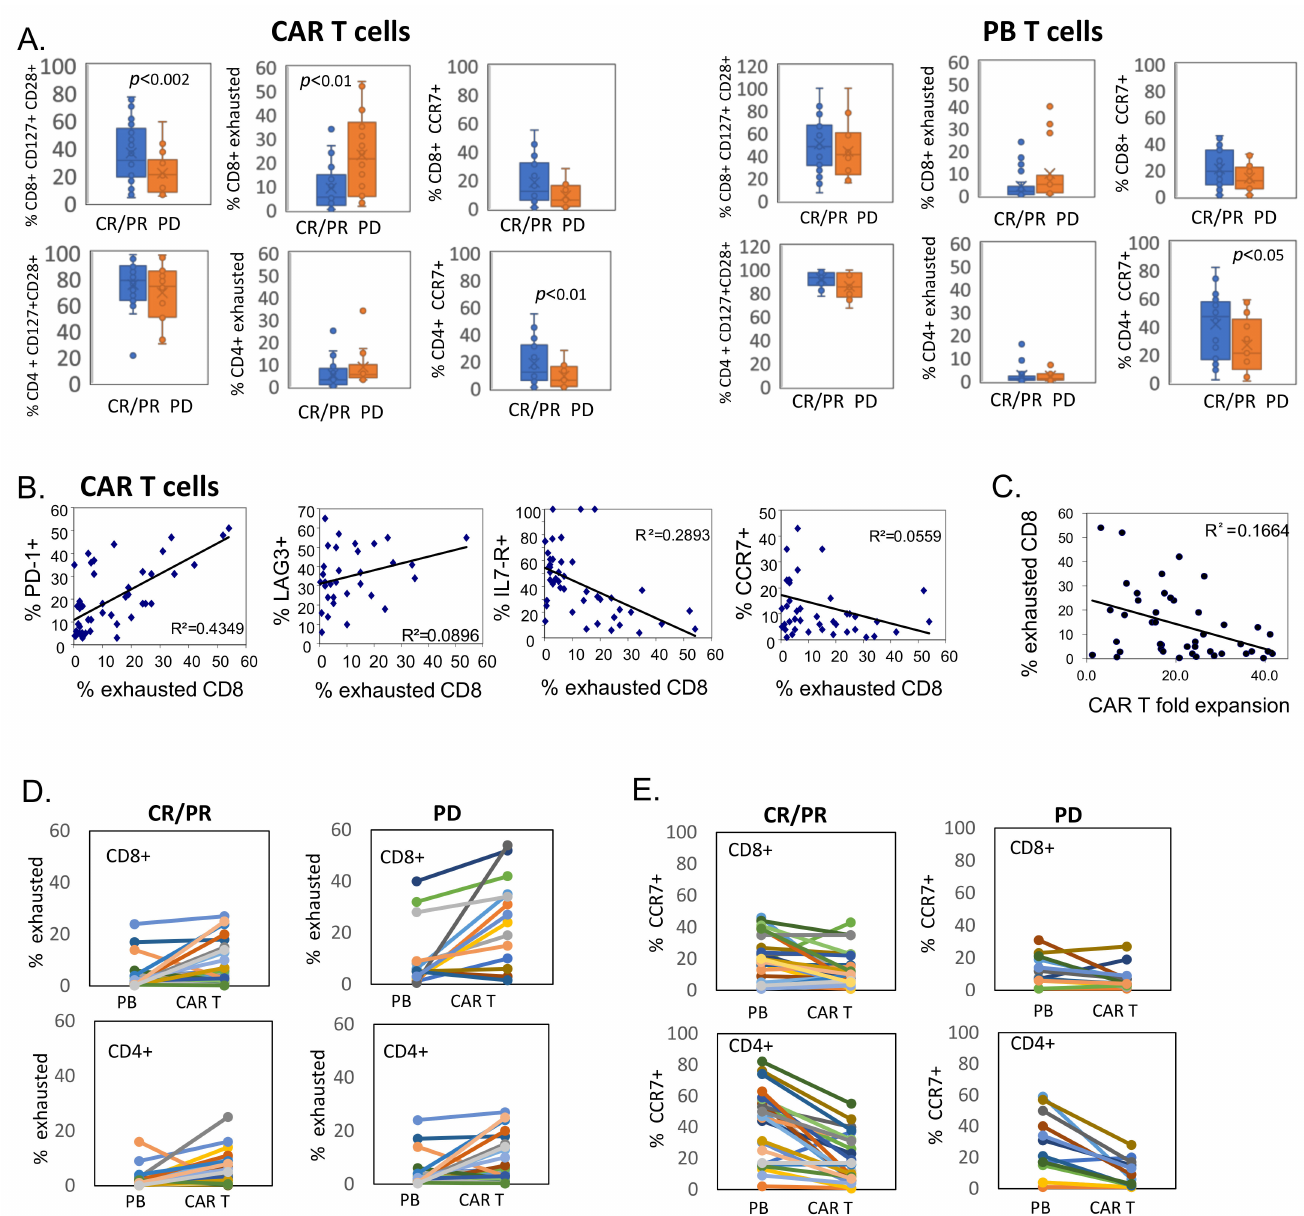
Figure 2. CD8 + T cells in peripheral blood and pre-infused CAR T cell products from non-responding patients display phenotypical features of exhaustion. Pre-infused CAR T cell products ( A ) and PB samples at the time of leukapheresis were analyzed by multiparameter flow cytometry. Frequency of CD28 + CD127 + , exhausted population (CD28 - CD57 + CD39 + ) and CCR7 in CD8 + and CD4 + T cells was established in each group (CR/PR, n = 28; PD, n = 14). ( B ) Spearman’s rho correlation (two-tailed) between the expression of PD1, LAG3, CD127 (IL-7R) and CCR7 on CD8 + T cells and the frequency of exhausted (CD28 - CD57 + CD39 + ) CD8+ cells in pre-infused CAR T cell products. ( C ) Spearman’s rho correlation (two-tailed) between the frequency of exhausted (CD28 - CD57 + CD39 + ) CD8+ cells in pre-infused CAR T cell products and CAR T product fold expansion during production. ( D ) Frequency of exhausted CD8 + and CD4 + cells in paired samples of PB and manufactured CAR T cells from CR/PR and PD patients. ( E ) CCR7 expression in CD8 + and CD4 + cells in paired samples of PB and manufactured CAR T cells from CR/PR and PD